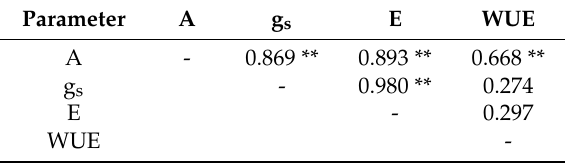
Table 1. Relationship between physiological parameters in rice treatment using Pearson’s correlation.